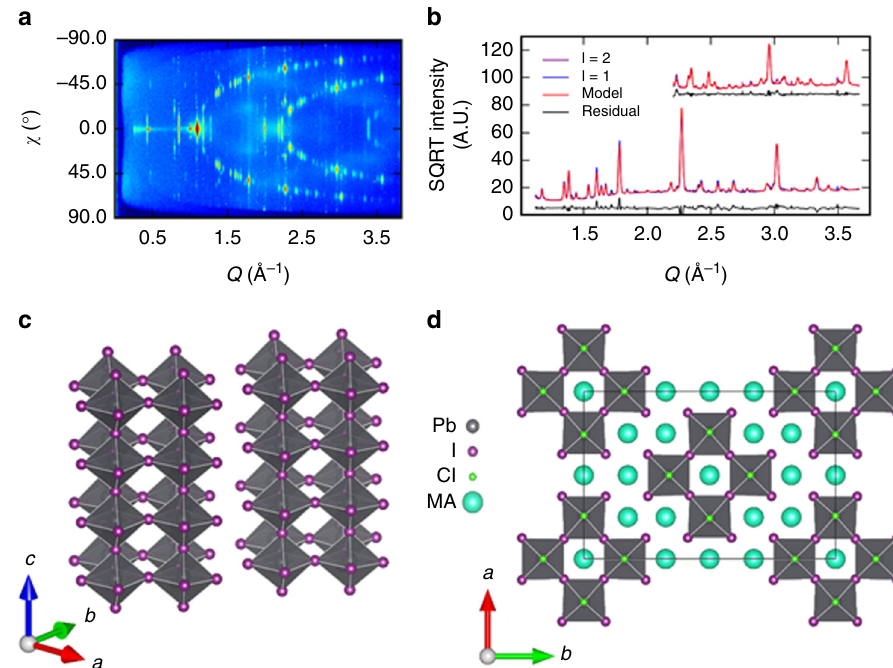
Fig. 1 Re fi nement of the precursor crystal structure. a GIXRD of precursor fi lm plotted as Q (scattering vector) vs. χ (azimuthal scattering angle). Apparent arcs are layer lines indexed to (hk1) and (hk2) re fl ections. b Re fi ned model and diffraction data for l = 1 and l = 2 layer lines. c Re fi ned precursor framework: 1D chains with layers of 4 corner-sharing lead-halide octahedra, halides are shown only as iodine and MA + cations are omitted for clarity. d Re fi ned precursor unit cell, MA + cations (cyan spheres) are added to preserve charge balance. Axial halide sites are colored green to emphasize probable